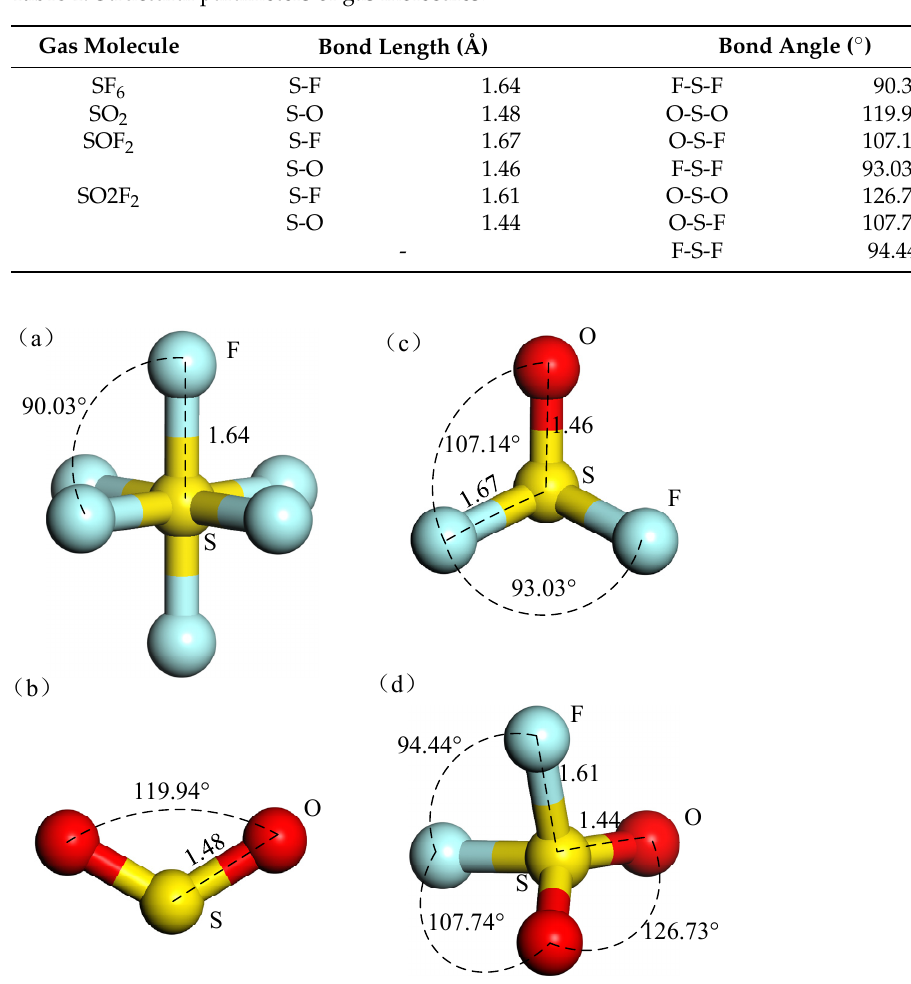
Table 1. Structural parameters of gas molecules.